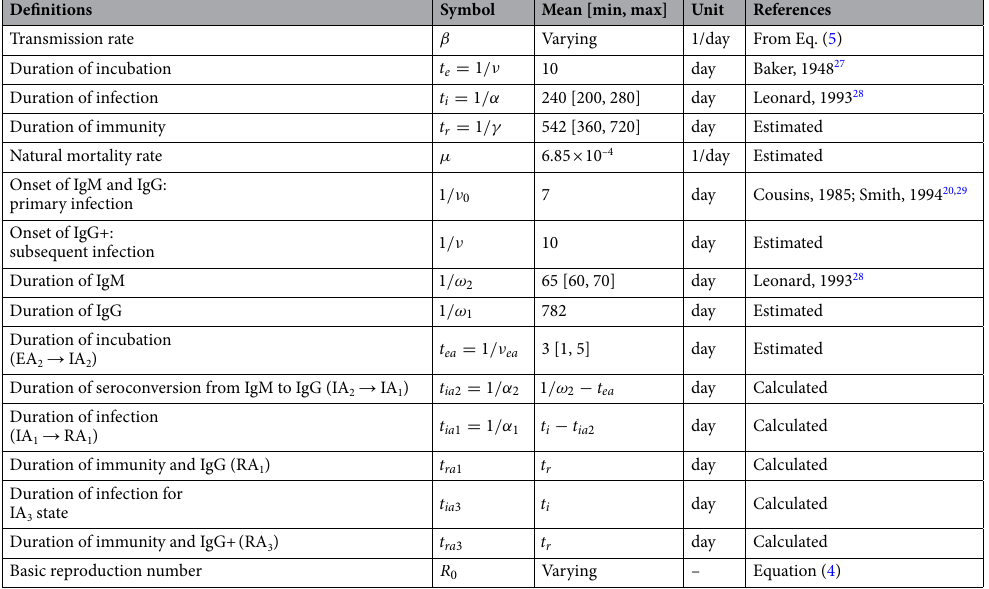
Table 1. Parameters and time durations of the infection and antibody